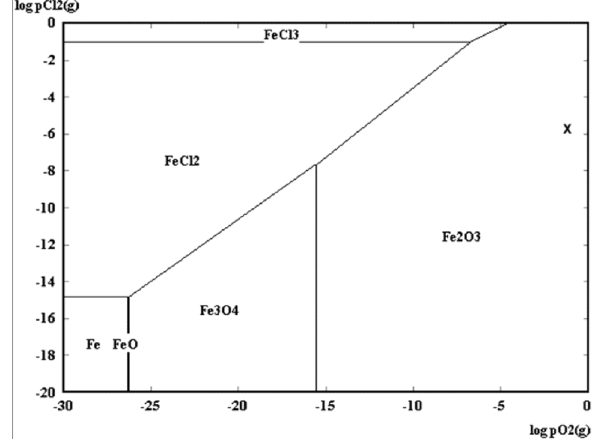
Figure 2. Fe-O-Cl phase stability diagram at 833 K. Equi- librium composition of experiment 1 is marked with X.